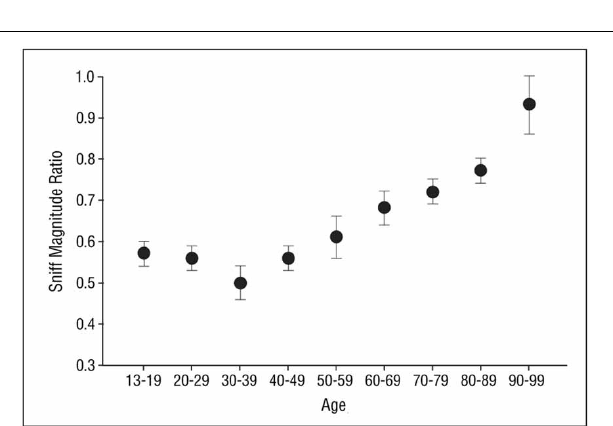
FIGURE 9 | Olfactory event-related potentials obtained from 12 younger (mean age: 24 years) and 12 older (mean age: 71 years) subjects using normal breathing or breathing after being trained to close the palate to minimize airflow from the mouth (velopharyngeal closure). Note the smaller amplitude and longer latency responses in the older group. From Thesen and Murphy (2001), with permission. Copyright©2001, Elsevier Science B.V.